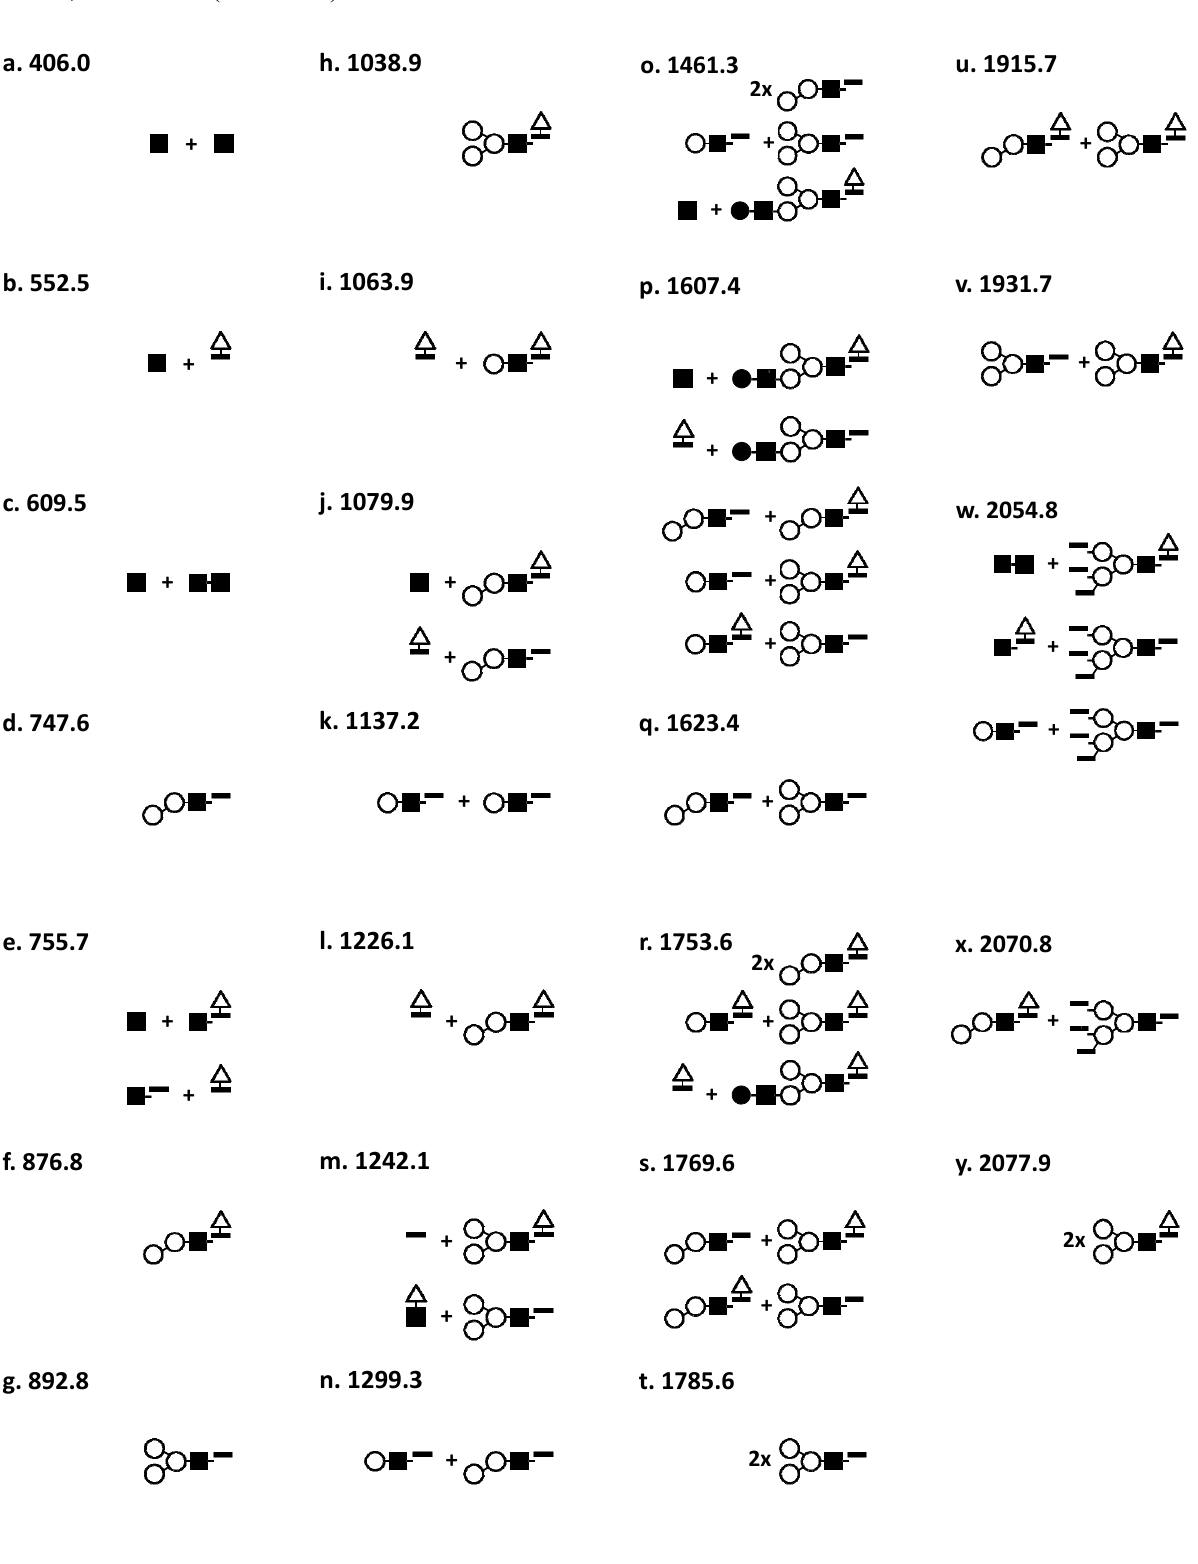
Figure 2. Oligosaccharide structures of hCG β cf. Structures identified in samples used in this study. The information for each structure includes; structure letter, schematic and molecular weight (Da). ■ , GlcNAc (221.2 Da); ○ , mannose (180.2 Da); ∆ , Fucose (164.2 Da); ● , Galactose (180.2